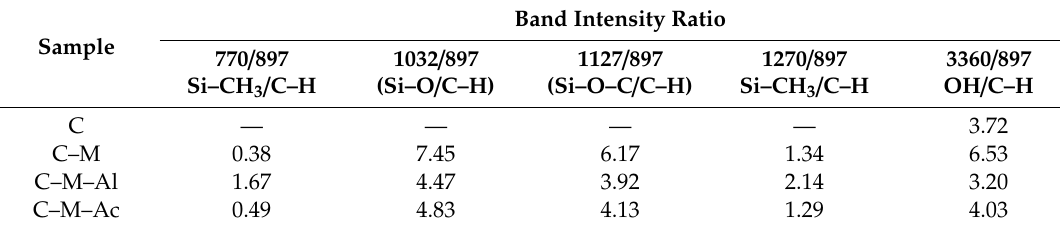
Table 2. Comparison of characteristic band intensity to basic bands observed on FT-IR spectra for cellulose silanized with